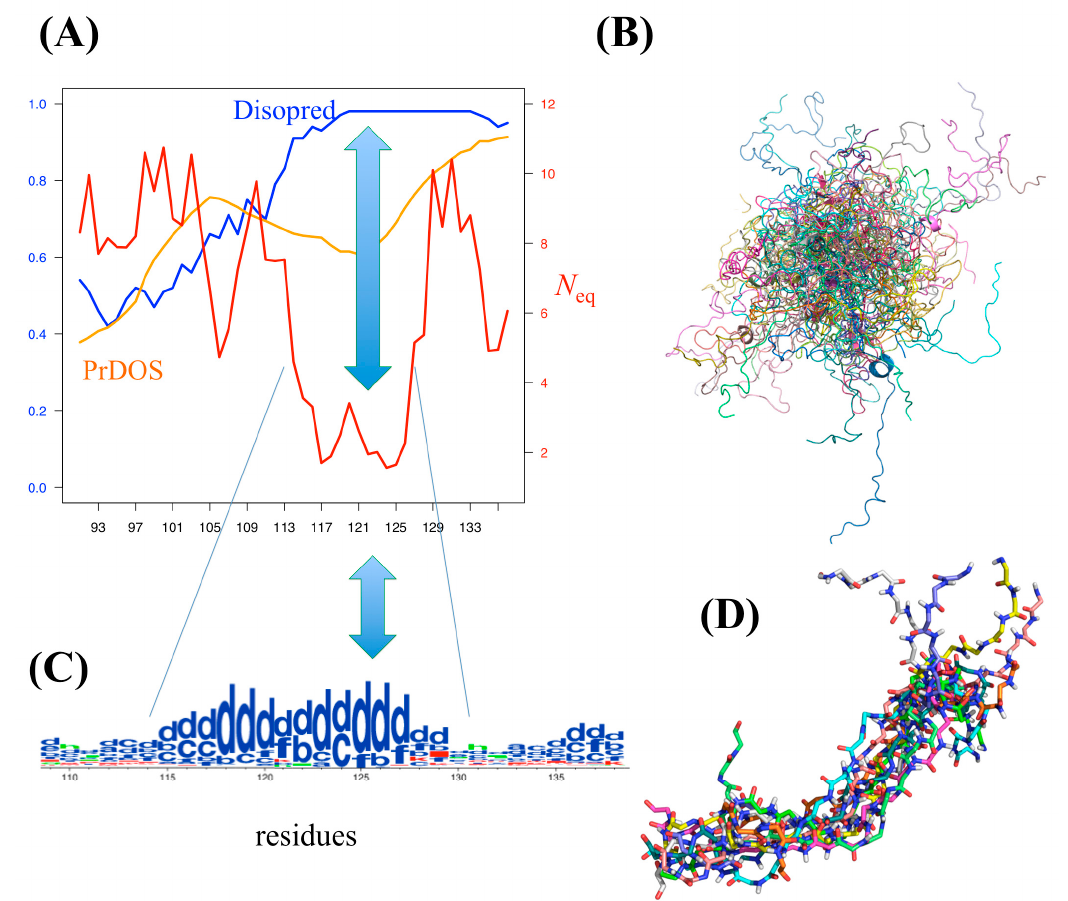
Figure 5. Example of alpha-synuclein, a solution-state ensemble from paramagnetic relaxation enhancement-Nuclear magnetic resonance (PRE-NMR) ensemble-restrained MD simulations (PED 3 9AAC entry). ( A ) A zoom on C-terminus of alpha-synuclein was done. Along the x -axis are shown, in orange, PrDOS prediction values and, in blue, Disopred3values. N eq values are represented in red. ( B ) A superimposition of hundreds of structural models from the ensemble. ( C ) Representation in terms of PBs shown with WebLogo [86], underlying the most contradictory position (low N eq and high disorder prediction values). ( D ) A dozen structural models superimposed on this region. Figure S1: Prediction disorder results of PrDOS on PED 3 dataset. For N eq (A) lower than 4. (B) between 4 and 8 and (C) higher than 8. Figure S2: Prediction disorder results on PED 3 dataset. (A) DisoPred3values ( x -axis) against PrDOS values ( y -axis) for N eq values higher than 8 (correlation is of 0.76). Figure S3: Analyses of prediction disorder results on PED 3 dataset per class of N eq . (A) DisoPred3values ( x -axis) and N eq classes ( y -axis). (B) PrDOS values ( x -axis) and N eq classes ( y -axis). Figure S4: N eq values for the alpha-synuclein, a solution-state ensemble from PRE-NMR ensemble-restrained MD simulations (PED 3 9AAC entry). Computation done with PBxplore software. Figure S5: PB distribution for the alpha-synuclein, a solution-state ensemble from PRE-NMR ensemble- restrained MD simulations (PED 3 9AAC entry). Computation done with PBxplore software and represented with WebLogo. Figure S6: Distribution of N eq and prediction disorder values & N eq versus prediction disorder results. Distribution of (A) IUPred2A values (in purple), and (B) ANCHOR2 values (in pink), (C) N eq values ( x -axis) against IUPred2A values ( y -axis) (correlation equals to 0.29). (C) N eq values ( x -axis) against ANCHOR2 values ( y -axis) (correlation equals to 0.25). Table S1: Correlation between N eq , Disopred3, PrDOS, IUPRed2A and ANCHOR2 values on PED3 dataset. Table S2: Evaluation of prediction rate according to N eq values for Disopred3